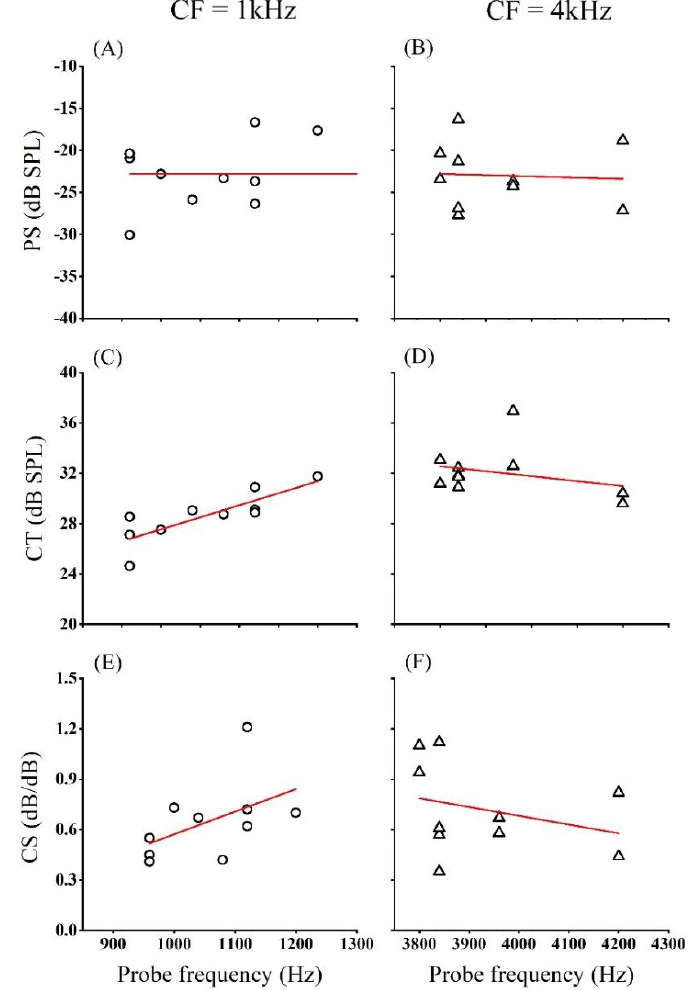
Figure 6. All participants’ three parameters and their linear regression fits at the CFs of 1 (left) and 4 kHz (right). PS, CT, and CS are plotted as functions of probe frequencies (from first to last panel). The triangles denote the values of PS, CT, and CS at the CFs of 1 kHz. The circles denote the values of PS, CT, and CS at the CFs of 4 kHz. ( A ) PS at 1 kHz; ( B ) PS at 4 kHz; ( C ) CT at 1 kHz; ( D ) CT at 4 kHz; ( E ) CS at 1 kHz; ( F ) CS at 4 kHz. Table 3. Statistics results of PS, CT, and CS at f p values centered 1 and 4 kHz.